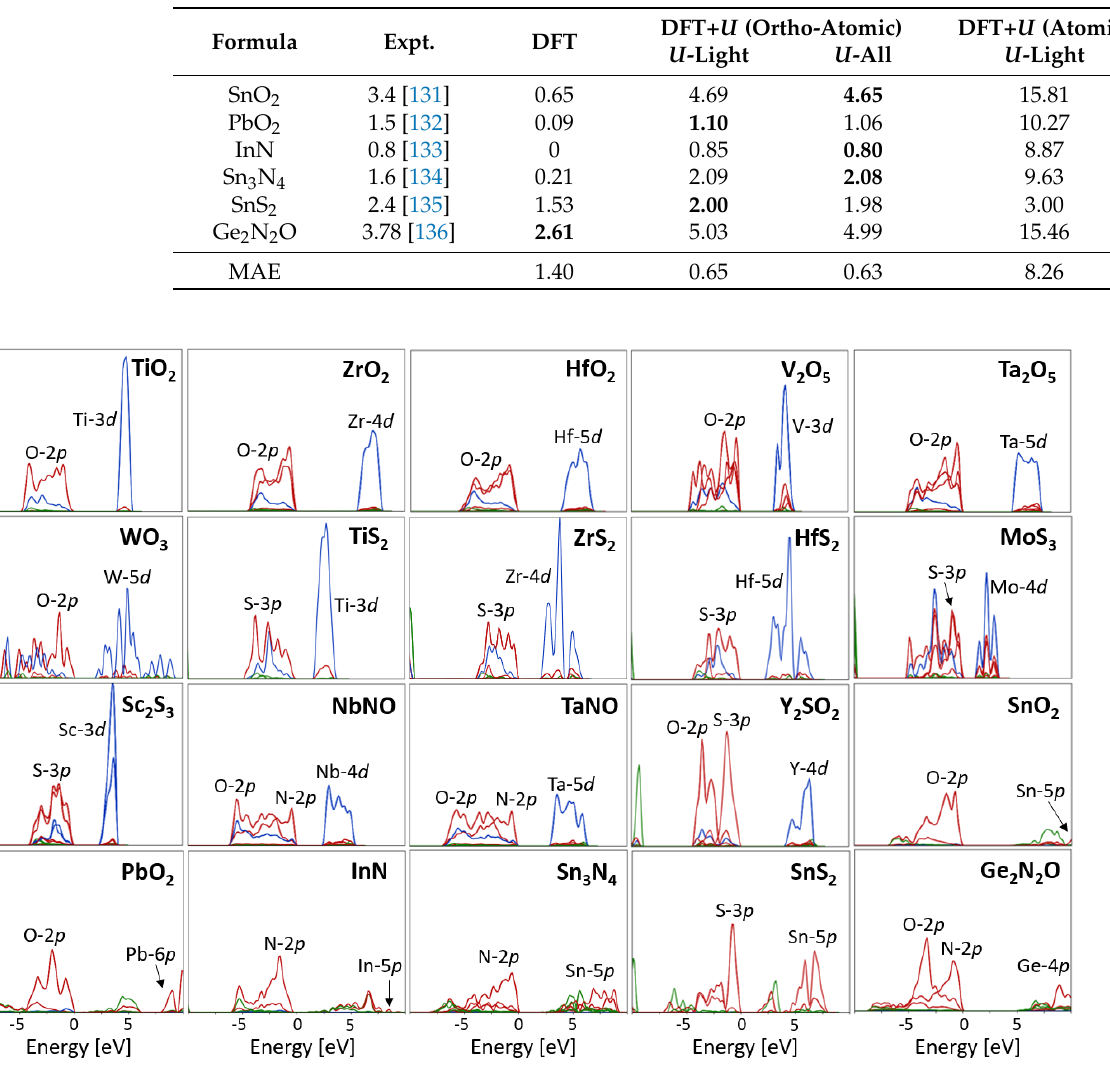
Figure 3. PDOS (in states/eV/cell) for all materials studied in this work obtained using DFT+ U with ortho-atomic projectors. The U correction was applied both to the d states of TM elements and to the p states of the light and p -block (group III-IV) elements (i.e., U -All). PDOS are color-coordinated such that s states are green, p states are red, and d states are blue. The zero of energy corresponds to the top of valence